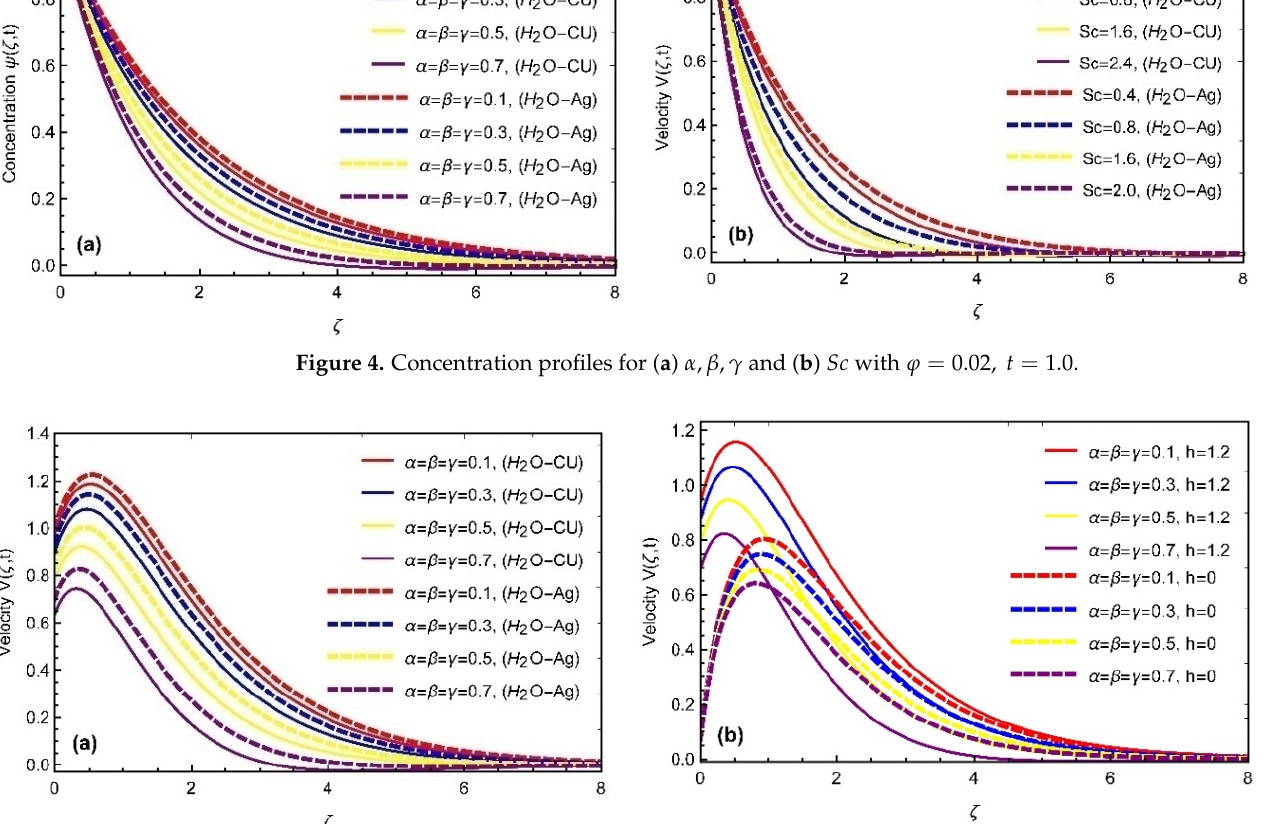
, ϕ = 0.02, t = 3 , 𝜑 = 0.02, 𝑡 = (cid:2871) , 𝜑 = 0.02, 𝑡 = (cid:2871) , 𝜑 = 0.02, 𝑡 = (cid:2871)